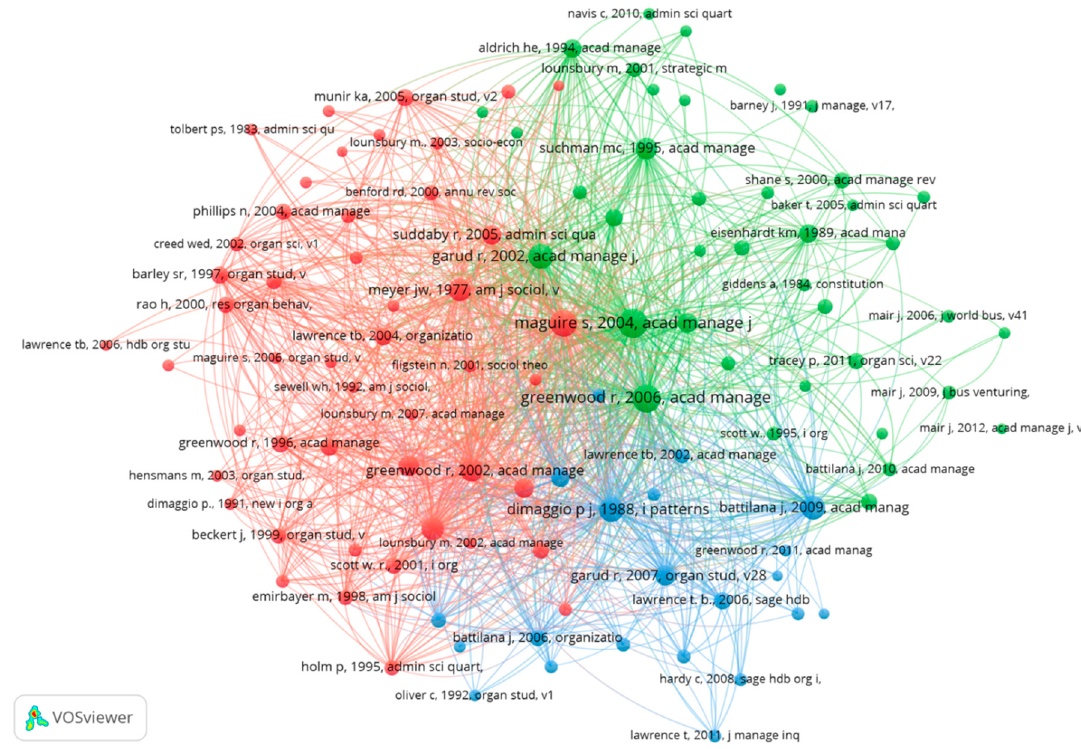
Figure 3. Article co-citation map.